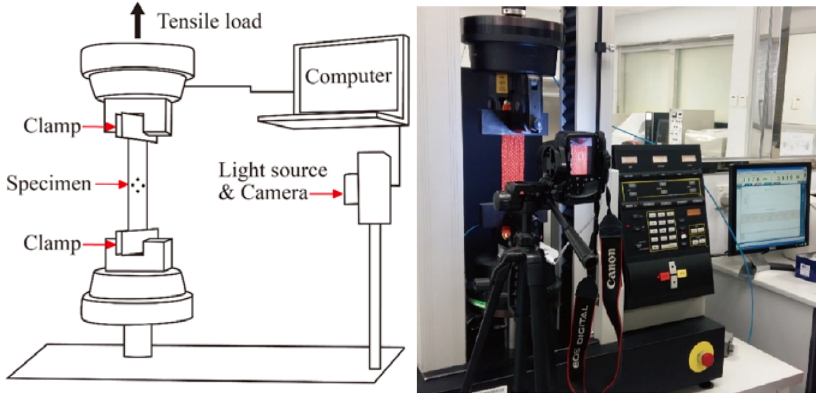
Figure 5. Schematic diagram and photograph of the fabric tensile testing system.